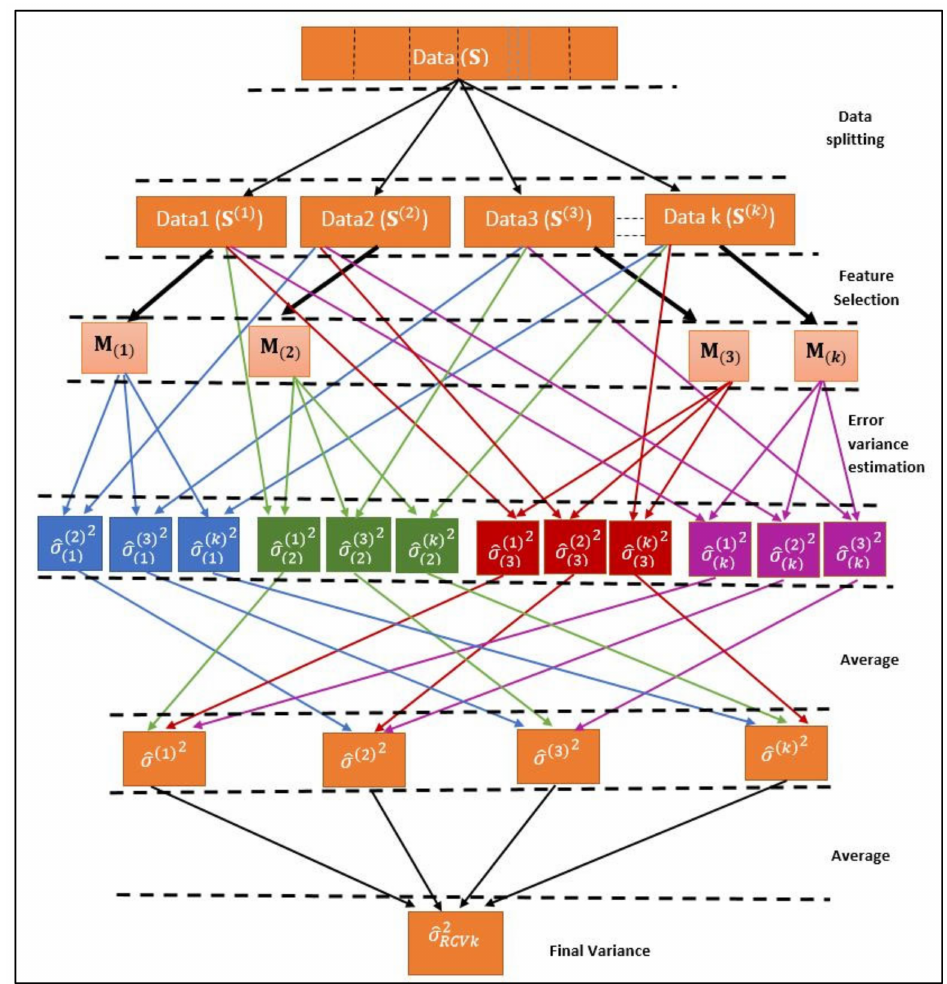
Figure 2. k-fold Refitted Cross Validation